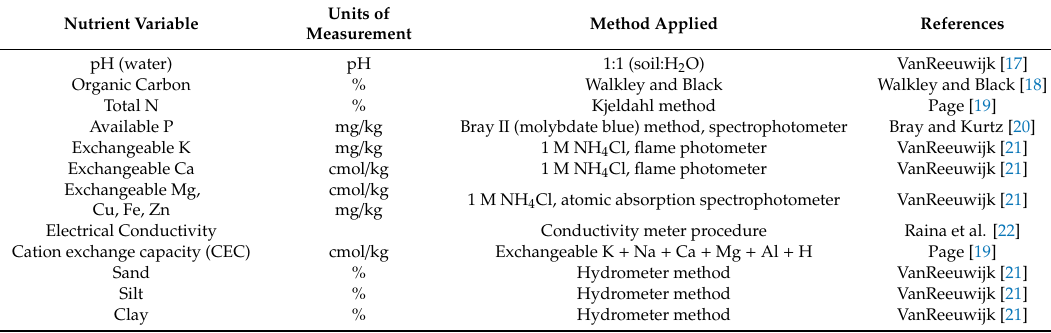
Table 1. Summary of methods used for soil